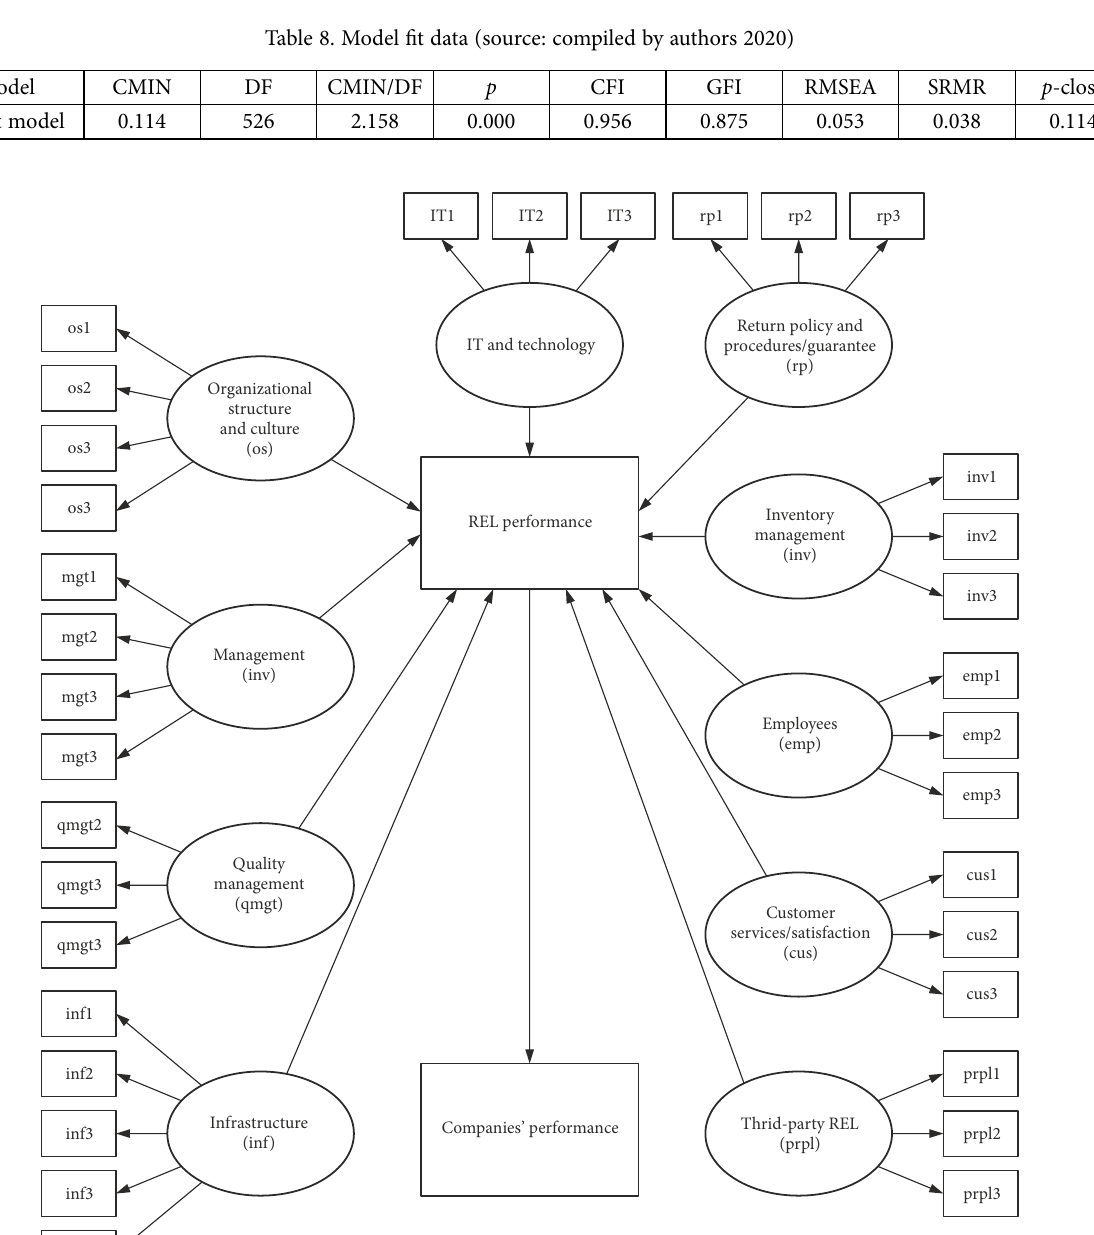
Figure 3. Research model (source: compiled by authors